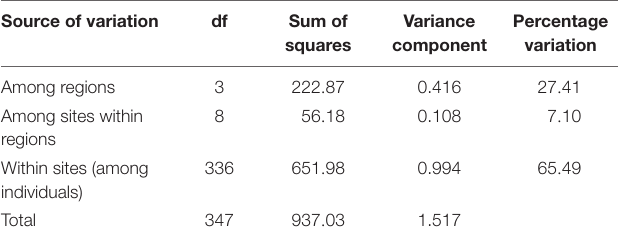
TABLE 2 | Global analysis of molecular variance (AMOVA) for E. radiata among the four regions, among the three sites within each region, and among the individuals